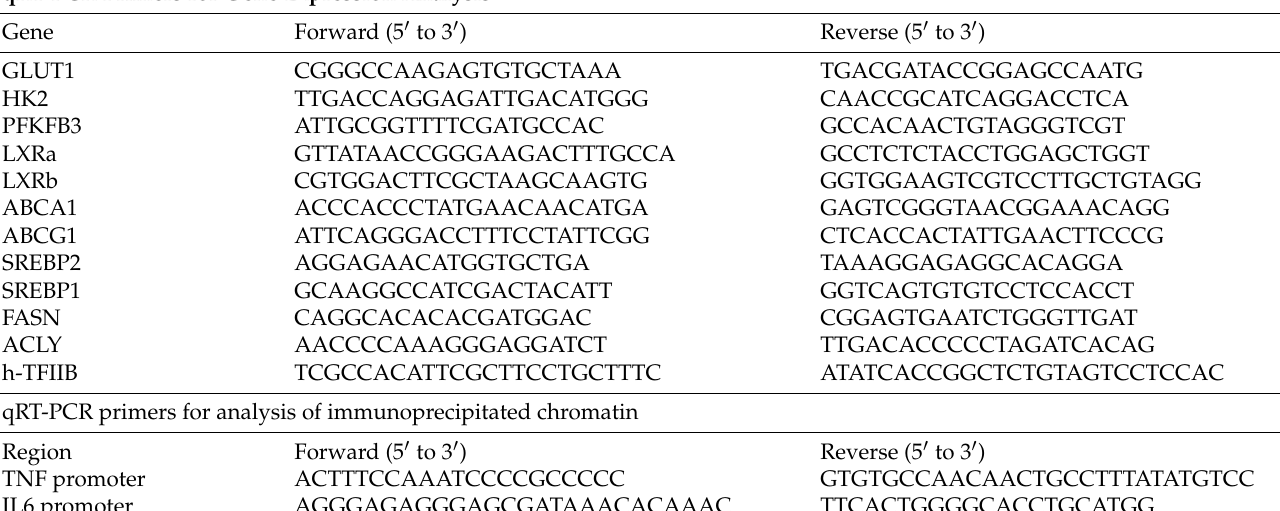
Table 1. Primers used for the qRT-PCR analysis of mRNA expression and immunoprecipitated